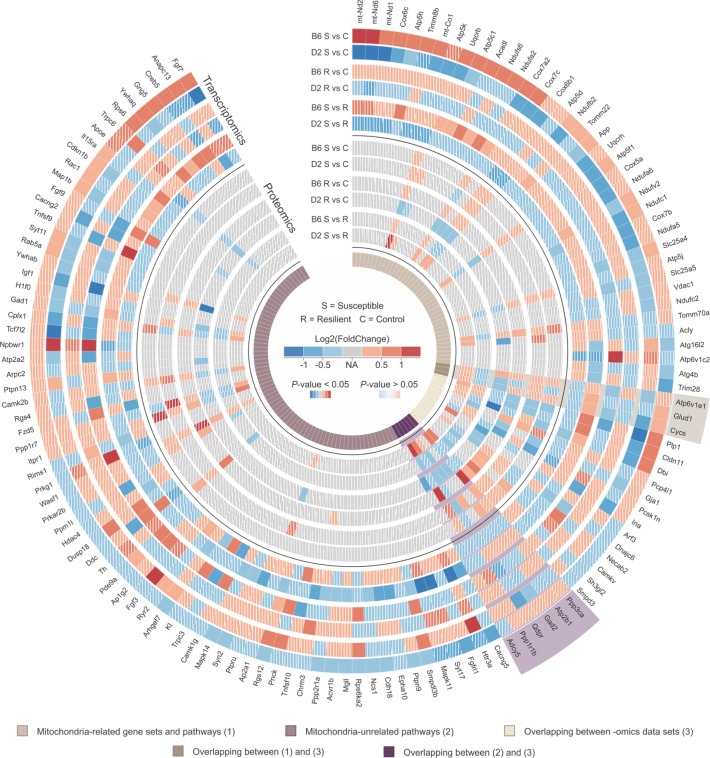
Common differentially expressed (DE) genes and proteins included in the enriched mitochondria-related gene sets and pathways in the BNST of B6 and D2 mice following CSDS.Merged heatmap showing the expression fold change (FC) and P-value of resilient vs. control, susceptible vs. control and susceptible vs. resilient comparisons from the BNST transcriptomic and proteomic analyses (data sets A and B, respectively). Only DE molecules (P < 0.01) in at least one of the 12 comparisons are shown. “Mitochondria-related gene sets and pathways” include “Mitochondrial Dysfunction,” “Oxidative Phosphorylation” and “Sirtuin Signaling Pathway” shown in Fig 4A and all gene sets shown in S3 Fig. All remaining canonical pathways included in Fig 4A are referred to as “Mitochondria-unrelated pathways”. Genes and proteins significantly DE in the same comparison between at least two BNST data sets are referred to as overlapping between–omic data sets and were selected based on results shown in S6 Table. Molecules with P > 0.05, are shown in diagonal stripe pattern, while those with P < 0.05 are shown with solid colors. Molecules not present in a data set are shown in gray. B6: C57BL/6NCrl; C: control; D2: DBA/2NCrl; R: resilient; S: susceptible.